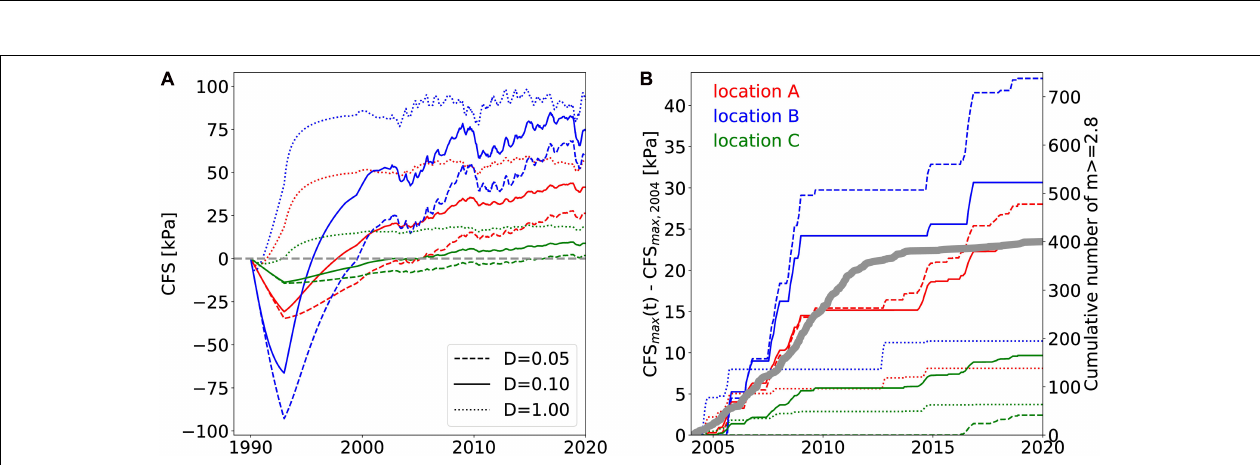
FIGURE 9 | Stress changes due to reservoir loading (60 m water column) ignoring fluid diffusion and calculated for receiver faults with the orientation of the 2017 M w 5.5 mainshock mechanism (strike = 313.5 ◦ , dip = 64.3 ◦ , rake = 173.1 ◦ ). Contour lines refer to stress values in units of MPa. Points refer to M ≥ 2.8 earthquakes (black = background, gray = aftershocks) in the depth range indicated in each title line. The colored crosses mark the three locations for which Figure 10 shows the total stress history, including pore pressure changes.